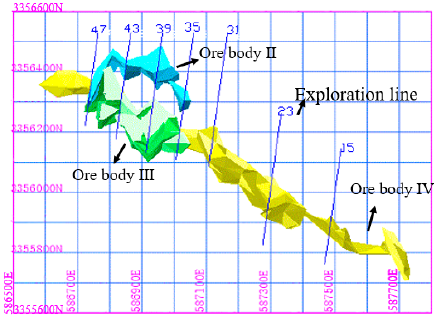
Figure 7. Top view of 3D visual model of No. II, III, and IV ore bodies from − 500 m to − 570 m.